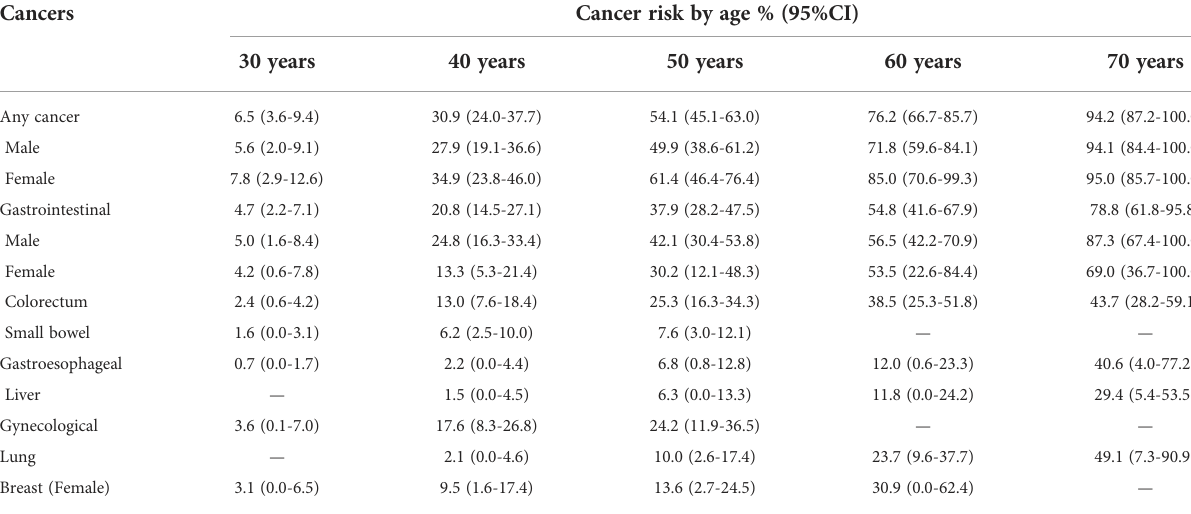
TABLE 3 Cumulative cancer risk by site and age in PJS patients.